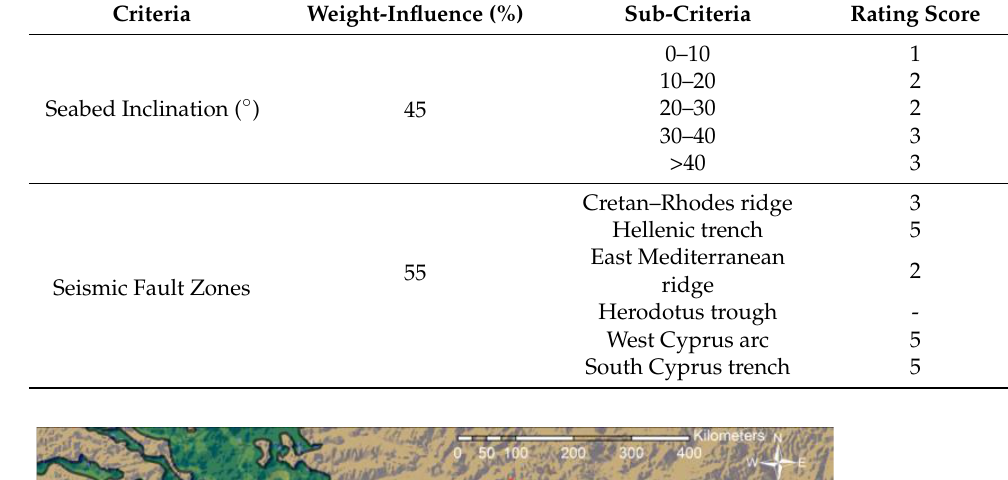
Table 1. Weight-influence and rating score of each of the adopted criteria and sub-criteria. Criteria Weight-Influence (%) Sub-Criteria Rating Score